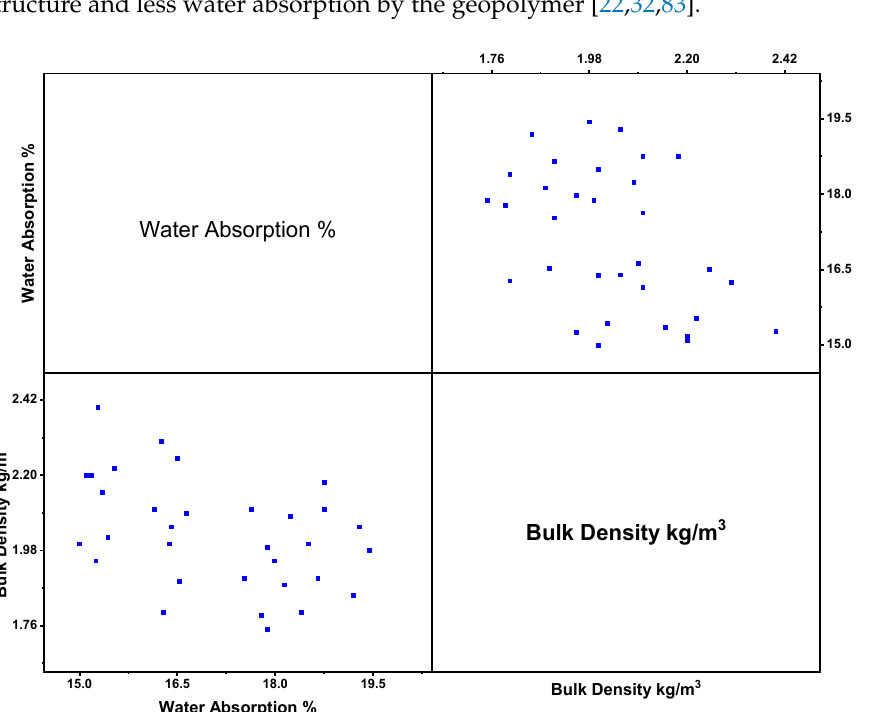
Figure 9. Scatter plot for WA (%) and BD (kg/m 3 ).